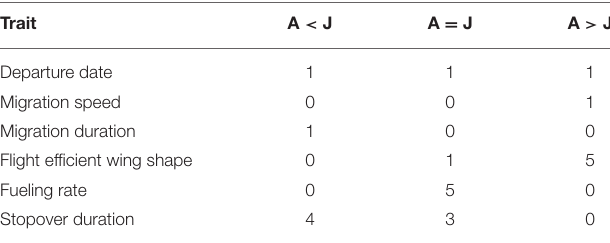
TABLE 3 | Summary of age effects in departure date and traits related to spring migration speed from published studies of migratory songbirds (see Table S2